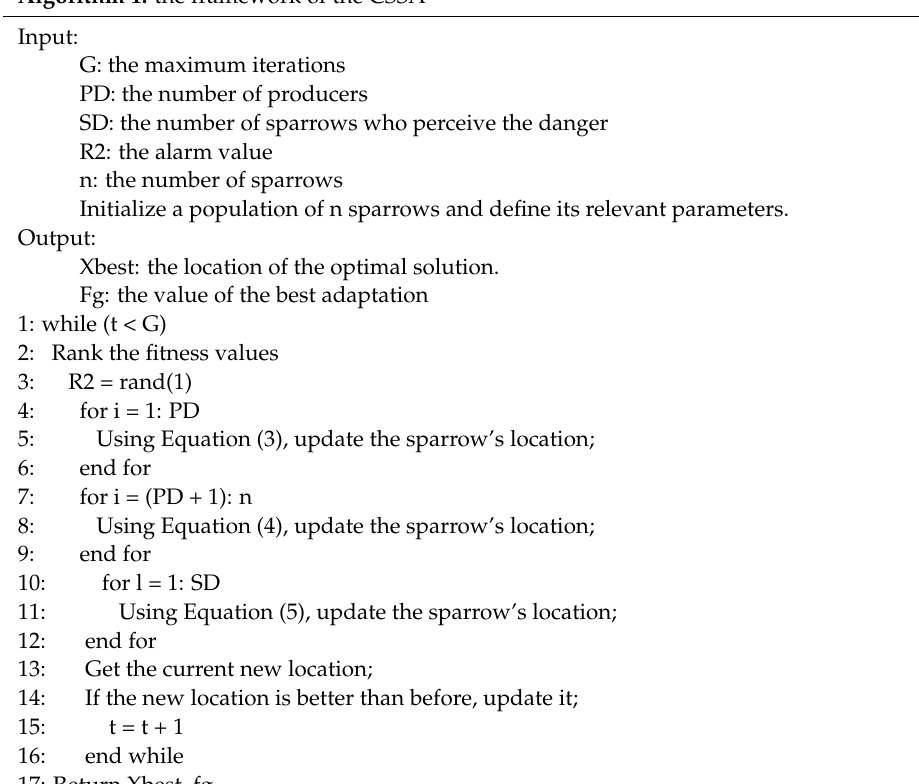
Algorithm 1: the framework of the